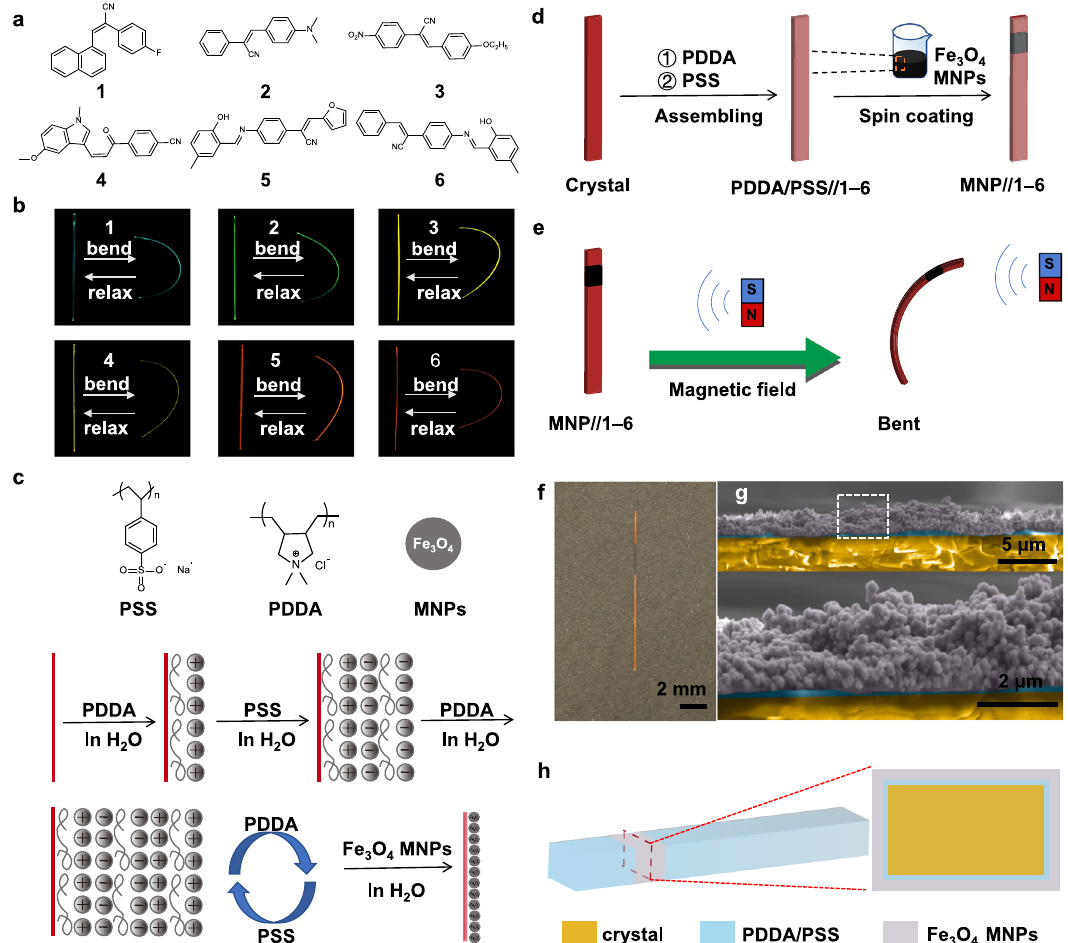
Fig. 1 Concept and preparation of magnetic hybrid fl exible crystals. a Chemical structures of elastic crystals 1 – 6 . b Reversible bending and unbending of acicular crystals 1 – 6 . The process was observed by using the emission of these crystals under 365 nm UV light for better contrast with the dark background. c A procedure for charge-driven assembly of magnetic nanoparticles (MNPs) onto fl exible organic crystals (Red vertical lines represent fl exible organic crystals). d Preparation of the hybrid crystals MNP// 1 – 6 . e Schematic diagram showing the mechanism of bending of MNP// 1 – 6 in a magnetic fi eld. f Photograph of MNP// 5 in daylight. g False-colored scanning electron micrographs showing the cross-section of the crystal hybrids. The crystal is shown in orange color, the polymer coating is in blue, and the Fe 3 O 4 MNPs are in light grey color. h Schematic cross-section of the magnetic hybrid fl exible crystals MNP// 1 – 6